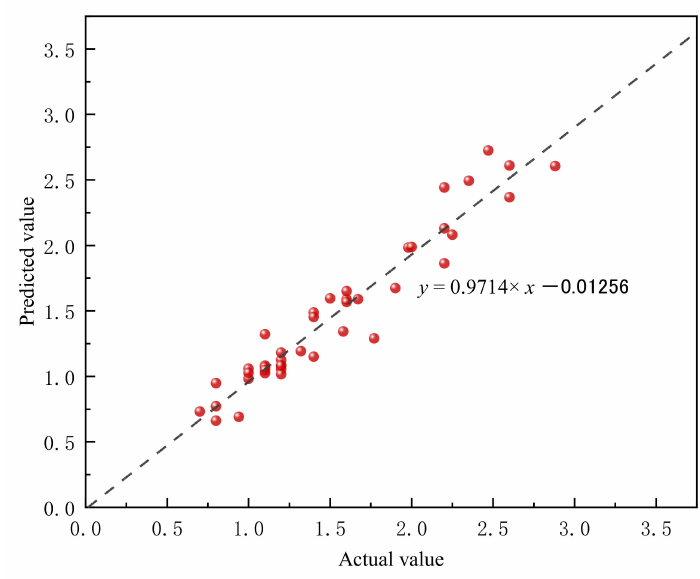
Figure 8. Predictive performance of SSA-BPNN model.